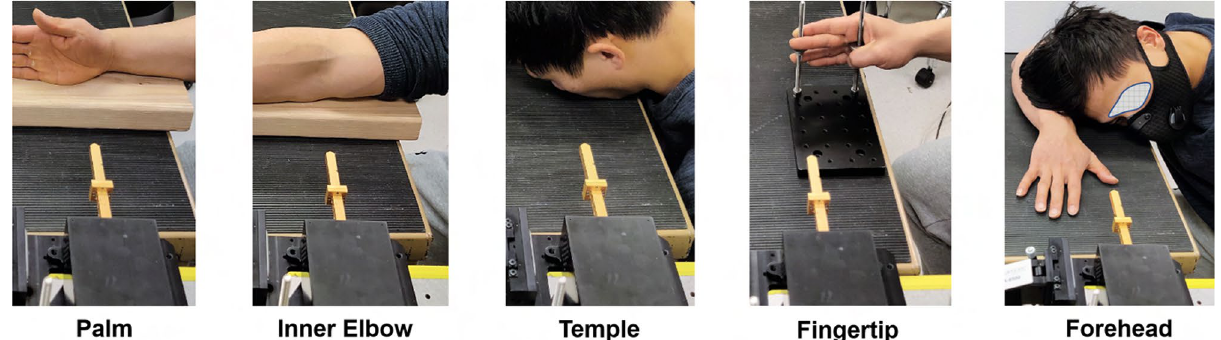
Figure 8. TPG measurement setups at various peripheral body ROIs, including palm, inner elbow, temple, fingertip and forehead. (Informed consent is obtained from this test subject for publication of identifying image.).